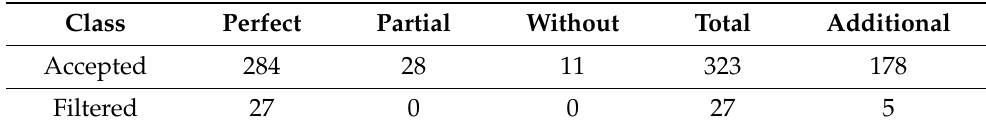
Table 2. Comparison of Accepted/Filtered miRNAture miRNA candidates with respect to the current human miRNA annotation. For a final classification of miRNAture miRNA candidates, the latter are intersected with current miRBase v.22 annotation on genomic loci level. Candidates were classified as follows: Accepted : Candidate passed evaluation stage, Filtered : candidate did not pass evaluation. Numbers for all candidates of a specific family overlap (Perfect), some overlap (Partial) and no overlap (Without). Furthermore we investigate for how many families candidates currently not contained in the annotation of the corresponding family (Additional) are predicted or Filtered during evaluation. This set contains families from the Partial and Without class. Perfect Partial Without Total